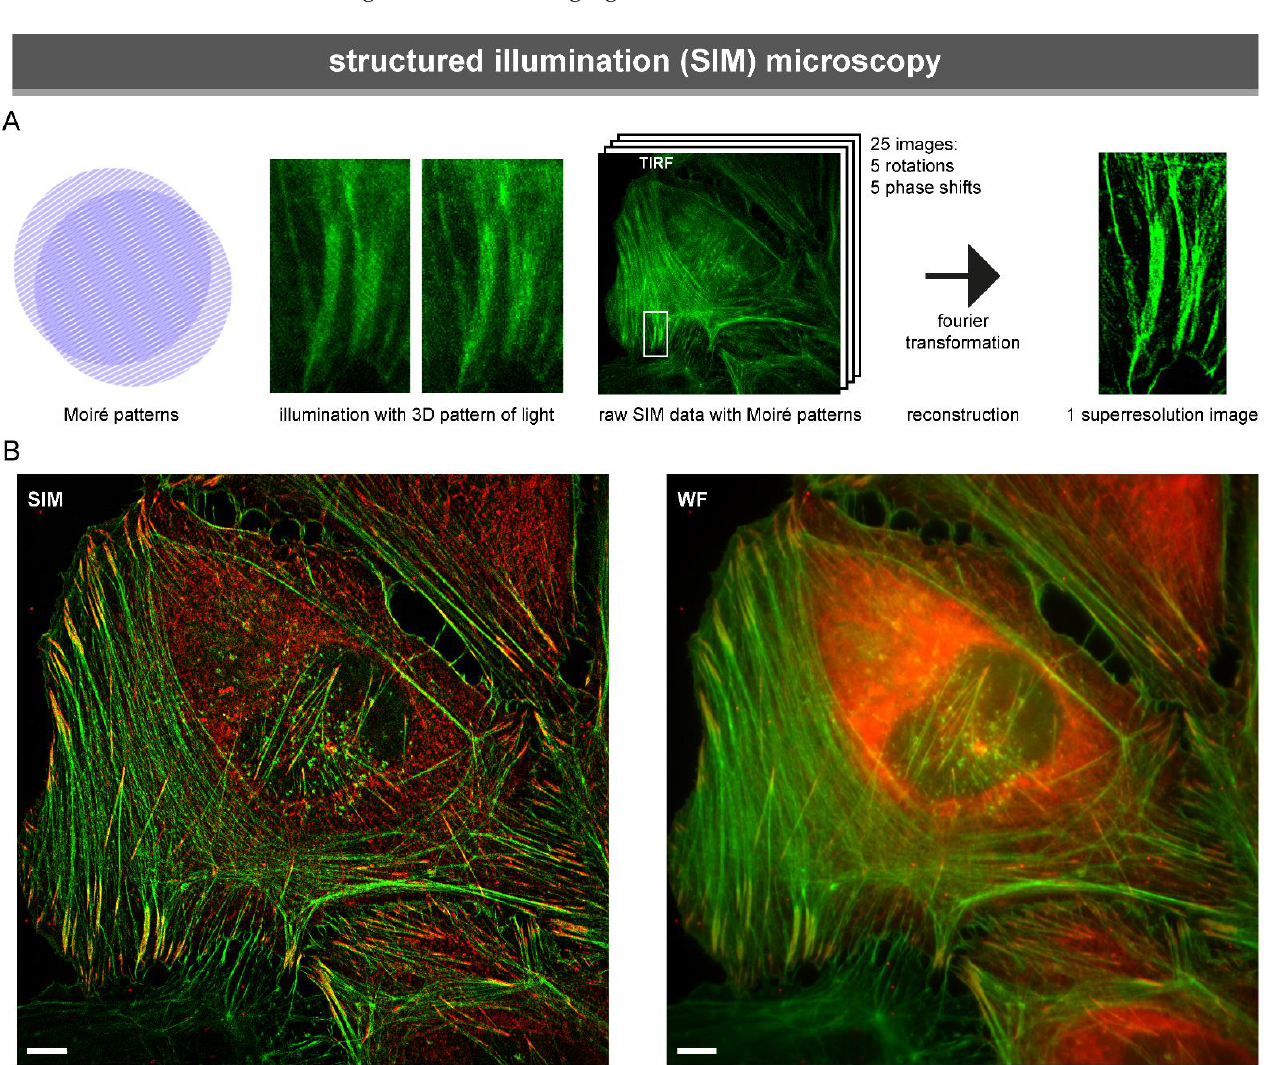
Figure 5. Structured illumination microscopy. ( A ) Schematic illustration of structured illumination microscopy (SIM). SIM makes use of Moiré patterns, an interference effect that occurs when two dense patterns are overlaid. Note that the formed Moiré pattern is always larger than the overlaid patterns. To create the Moiré patterns in SIM samples, they are illuminated with a three-dimensional pattern of light, which means parts of the sample are not illuminated (black stripes in the raw data). The pattern of light is rotated to allow for the reliable reconstruction (mainly through Fourier transformations) of a super-resolution image based on the collected Moiré patterns (orientation change of the black stripes in the raw data). The illumination pattern is also shifted to allow data collection from the whole image. In total, 25 raw images are typically collected to create 1 super-resolution image. ( B ) Reconstruction of the widefield (WF) or super resolution (SIM) image of a U2OS cell stably expressing paxillin-mCherry (red) and stained with phalloidin-CF405 (pseudocolour green). Scalebar: 5 µm.